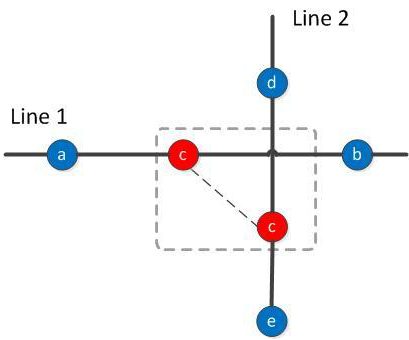
Fig 1. Sketch of Transfer Node and Transfer